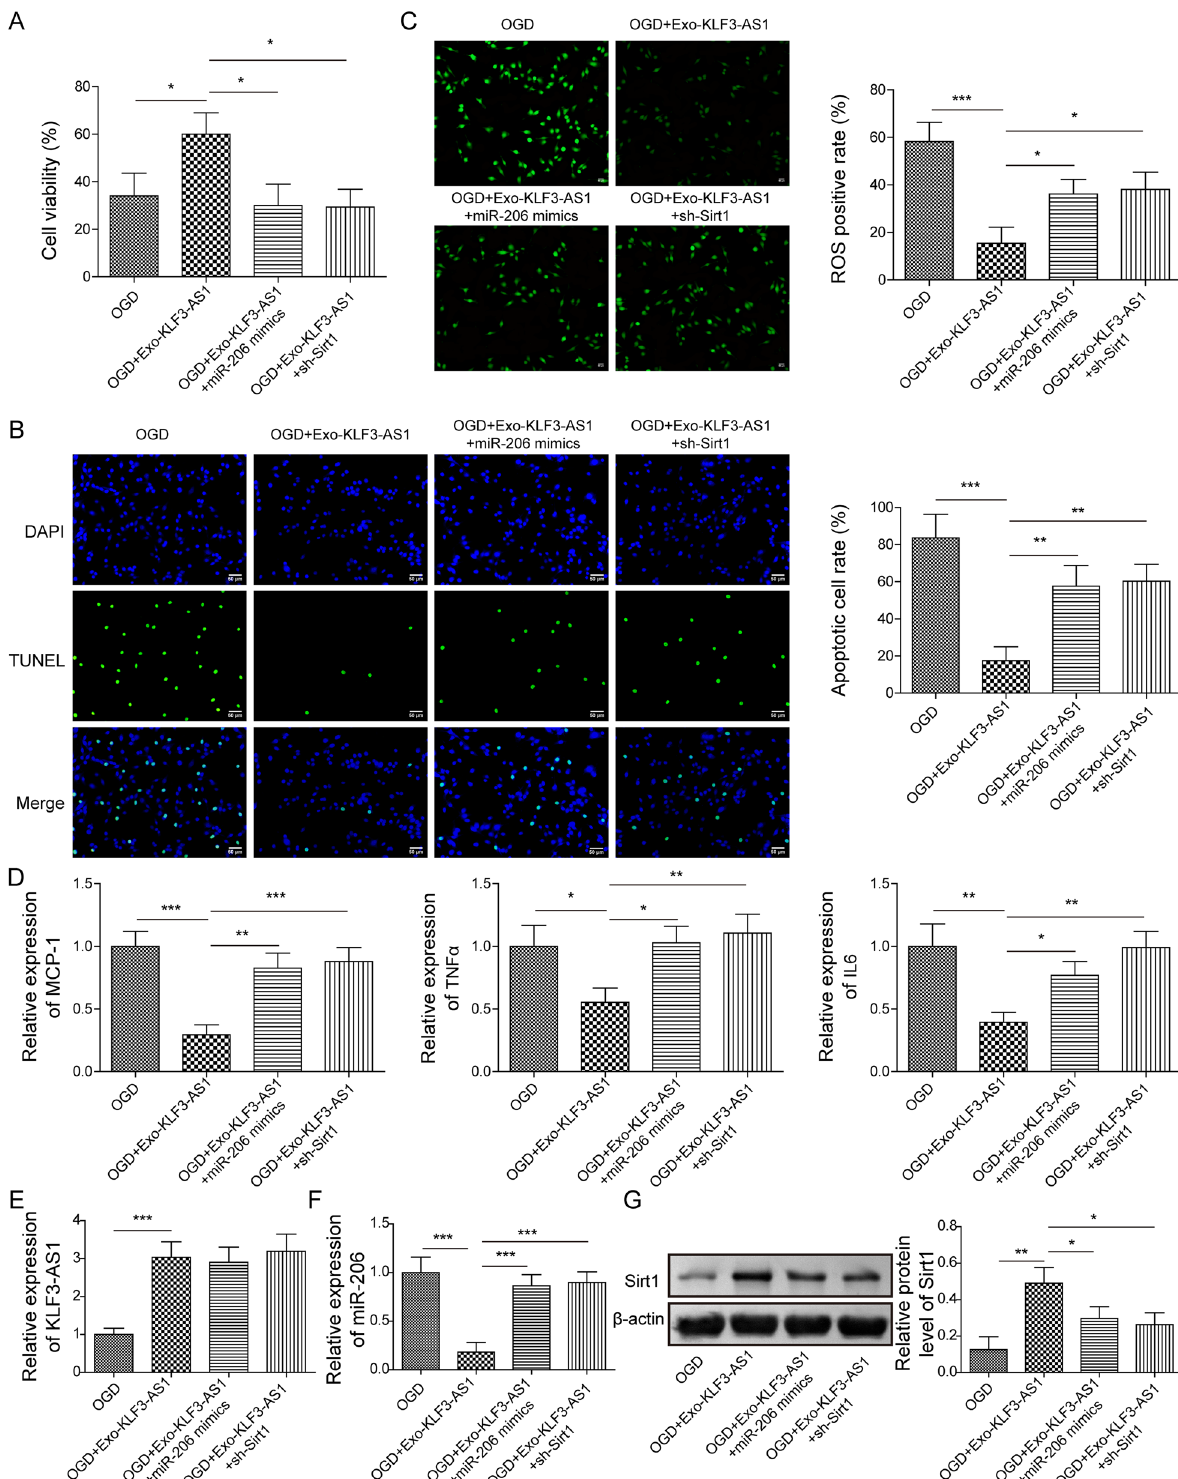
Fig. 6 The effect of Exos-KLF3-AS1 on cerebral I/R injury could be overturned by miR-206 overexpression or Sirt1 knockdown. Cells transfected with miR-206 mimic or sh-Sirt1 were subjected to OGD, prior to supplemented with Exos-KLF3-AS1. A Cell viability was assessed. B TUNEL-positive cells. C The production of ROS. D The mRNA levels of MCP-1, TNFα and IL-6. E , F qRT-PCR detection of KLF3-AS1 ( E ) and miR-206 ( F ). G Sirt1 protein was determined. Values were expressed as mean SD of three separate determinations in the in vitro assays. *P < 0.05, **P < 0.01, ***P < ±